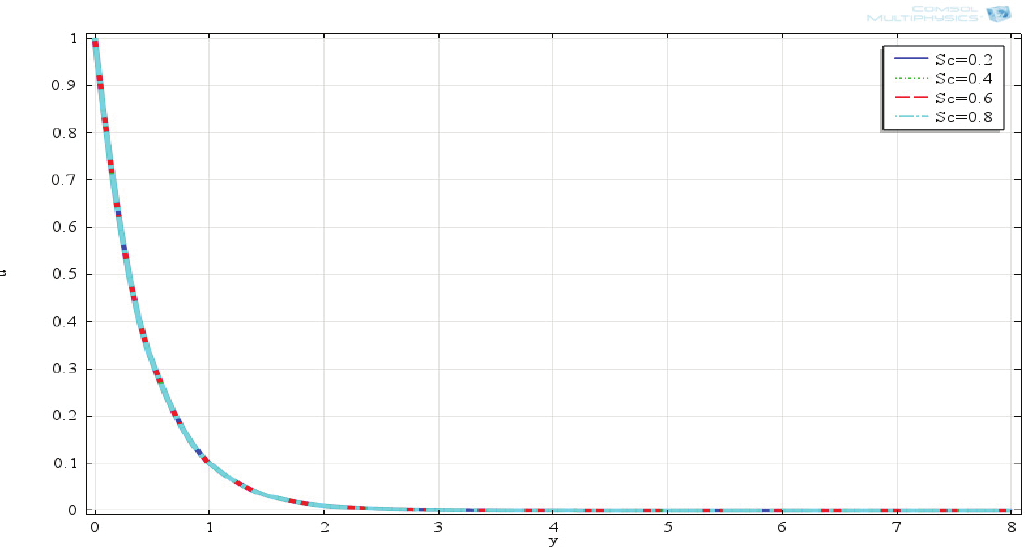
Figure 8: Steady state velocity profiles for different values of Sc at